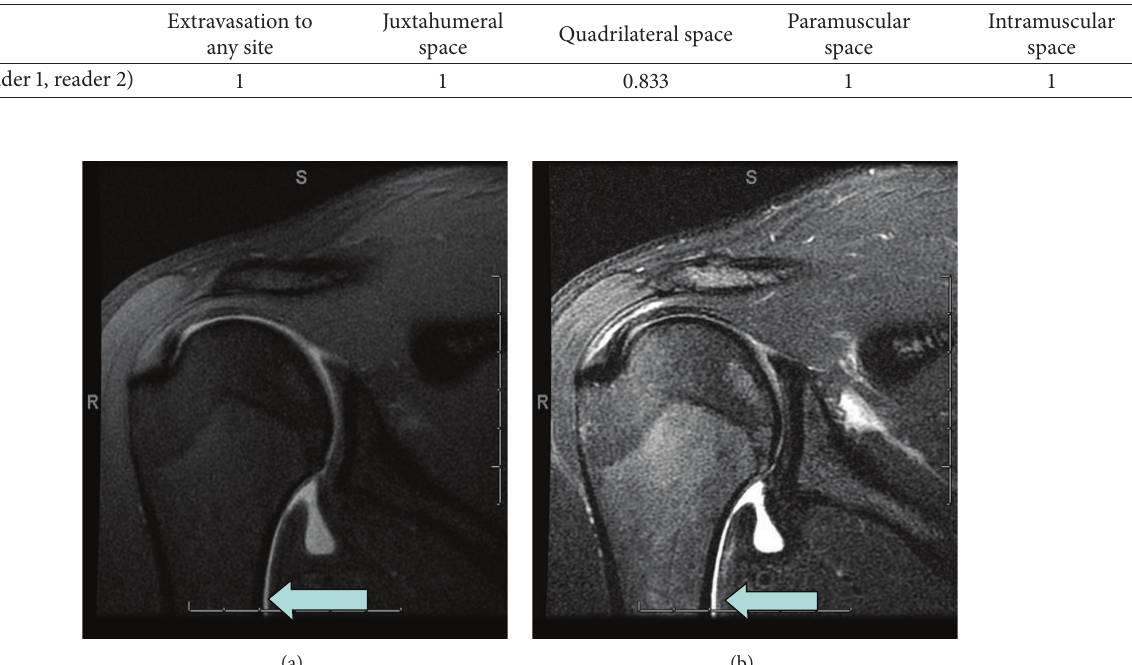
Figure 1: Case 8. Oblique coronal T1 and T2 demonstrating contrast/fluid extending along the medial humerus and off the field of view (arrow), consistent with extra-articular extravasation.